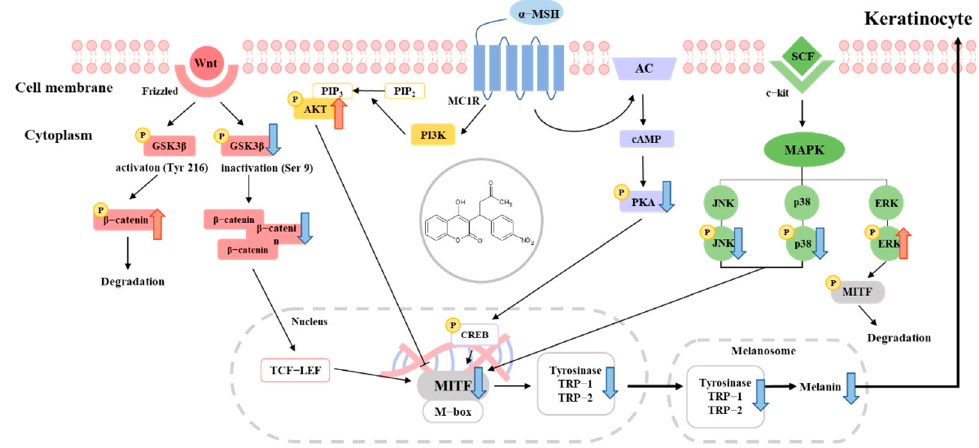
Figure 7. Schematic diagram of the proposed mechanism regulating the inhibitory action of aceno- coumarol on melanogenesis.